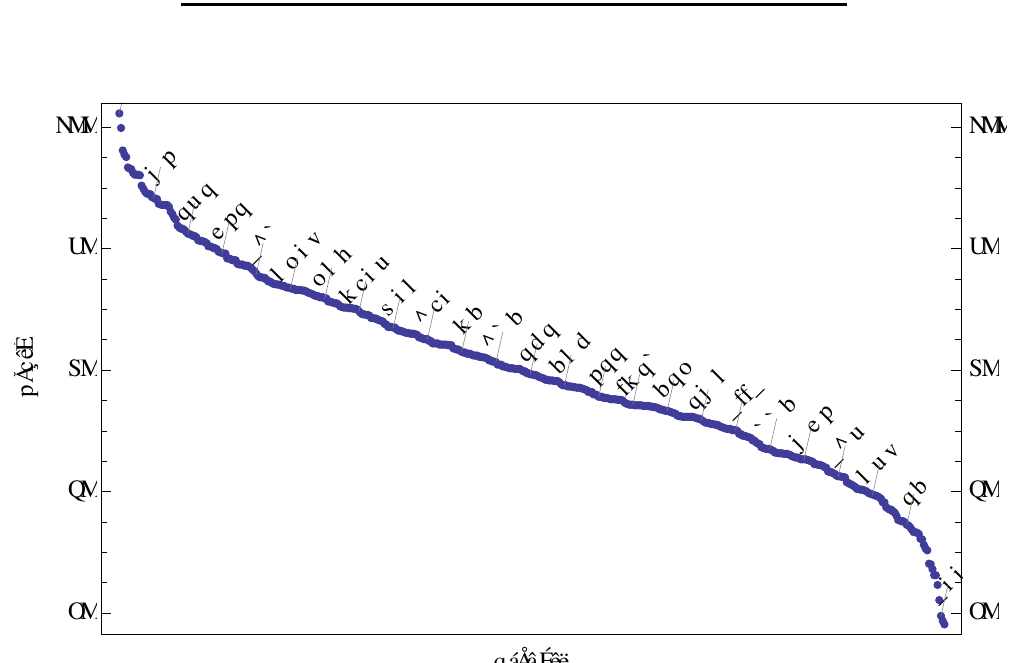
Figure 6. Sorted scores computed with Dynamis aggregation on 3 October